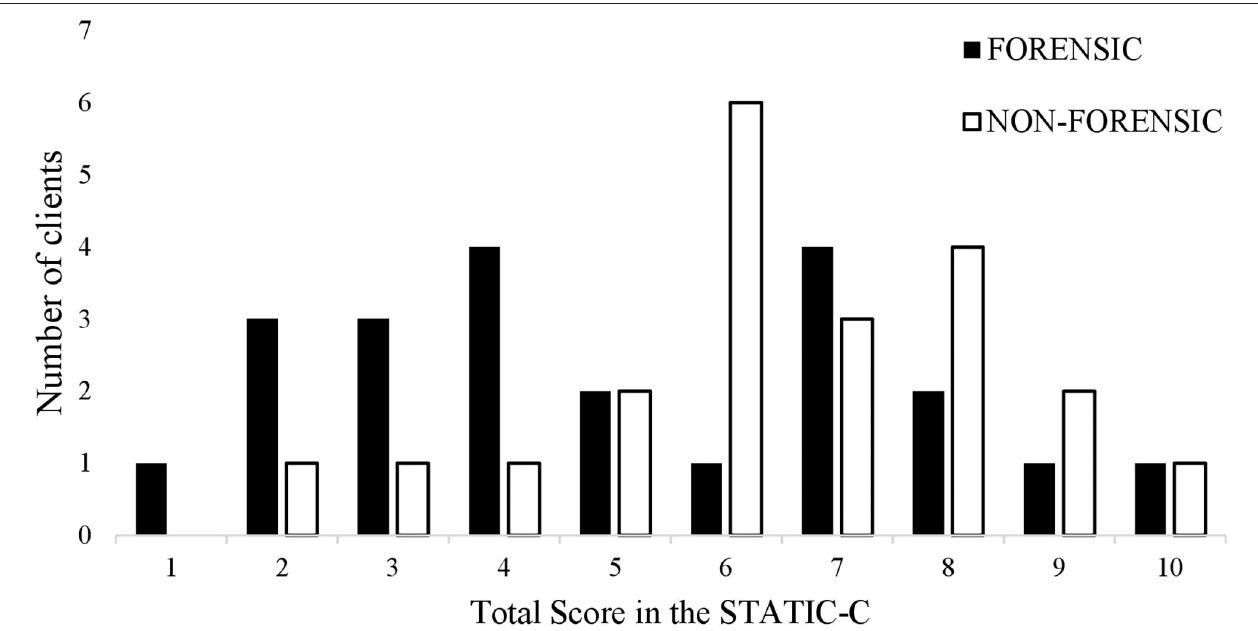
FIGURE 2 | Number of forensic and non-forensic clients with a specific total score in the